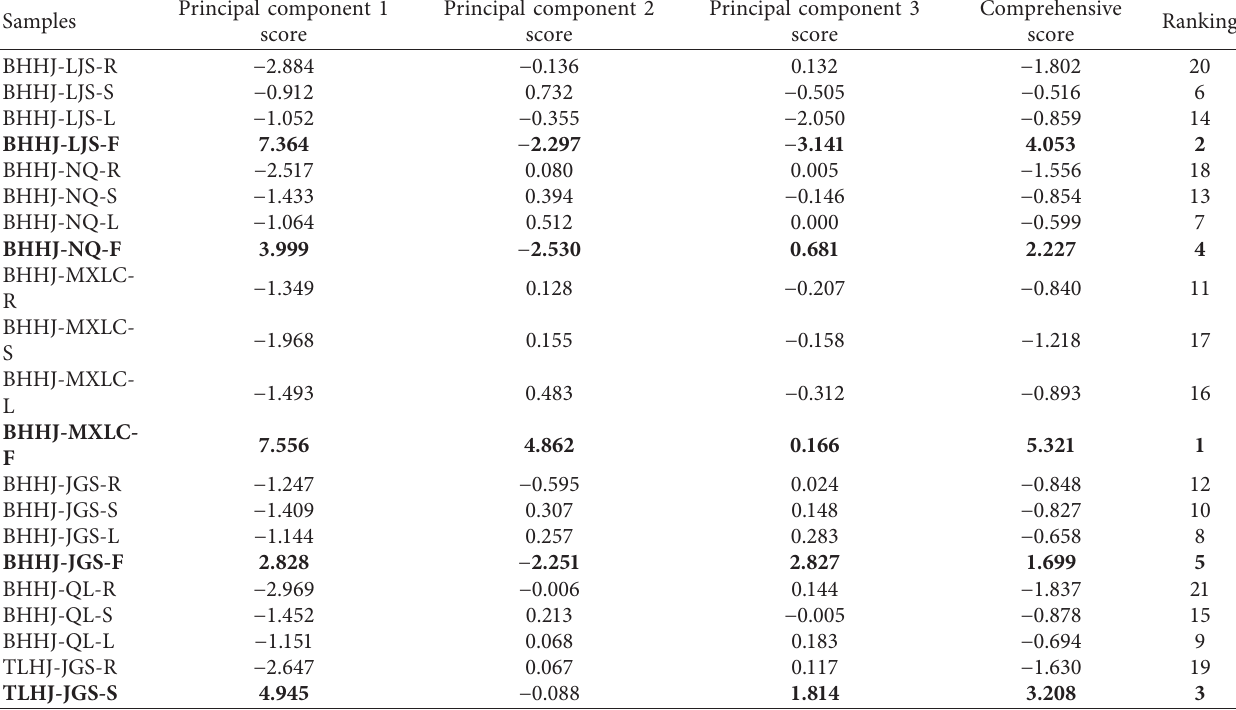
Table 9: Principal component score.